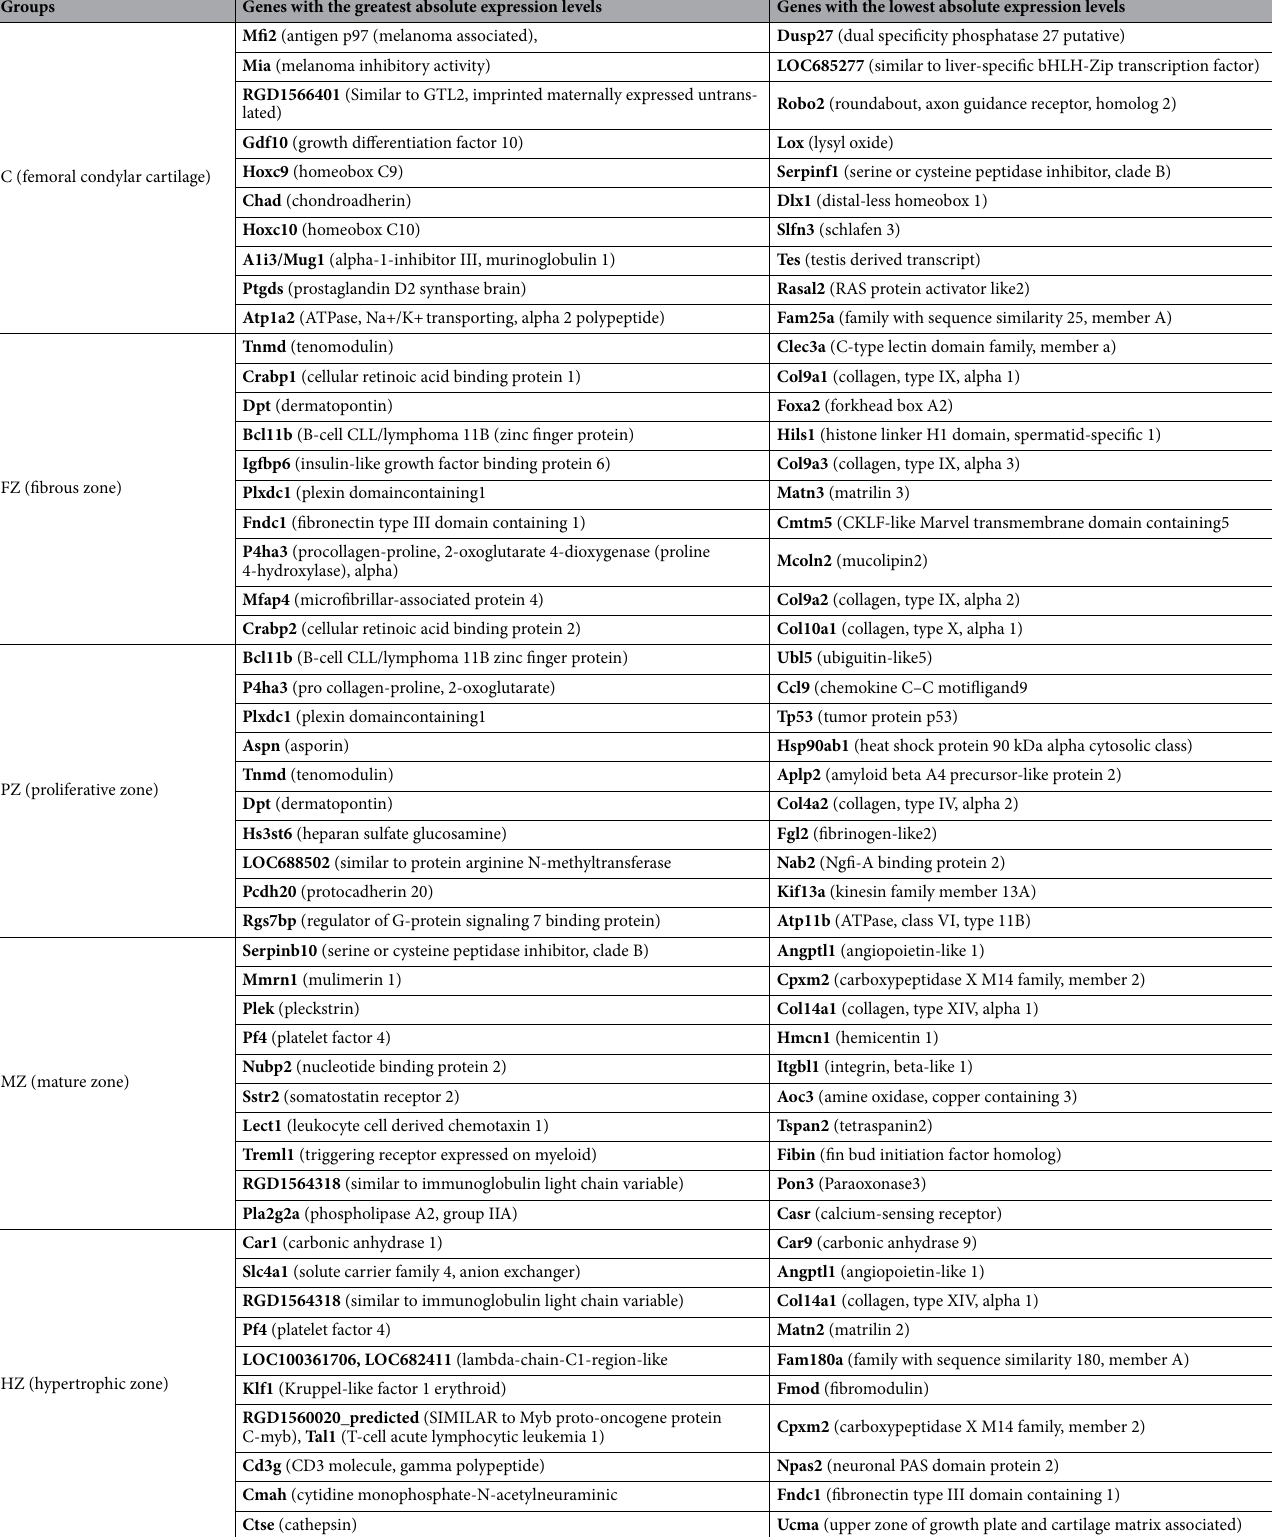
Table 1. The top ten annotated genes with the greatest/lowest absolute expression levels in the FCC and four zones of MCC